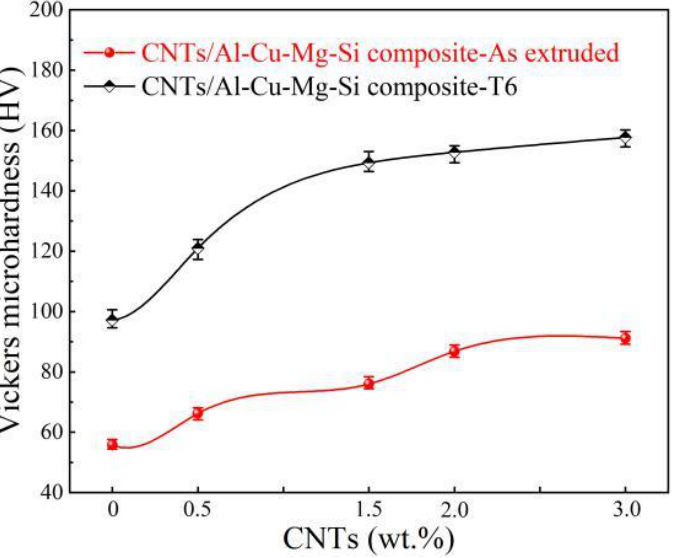
Figure 9. Results from the microhardness test of CNTs/Al-Cu-Mg-Si composites.